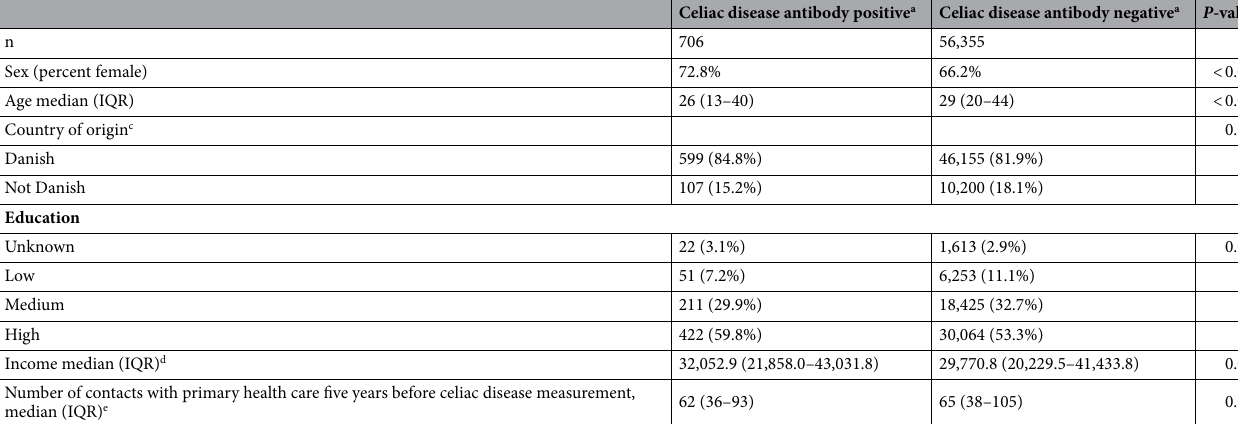
Table 1. Characteristics of individuals with positive and negative celiac disease antibody test results. IQR Interquartile range. a positive celiac antibody test was defined as: IgA/IgG TTG of at least 7 U/ml or IgG DGP of at least 10 U/ml and a negative test was defined as IgA /IgG TTG under 7 U/ml and IgG DGP under 10 U/ ml. b Chi square tests were used to test differences between categorical variables. For continuous, (age and registry and grouped into Danish vs. non-Danish (comprising migrants and descendants of migrants). d The household equivalized income in Euros. Income was missing for 361 individuals. e The total number of contacts with primary health care, recorded from the reimbursement system the five years before celiac disease antibody measurement.